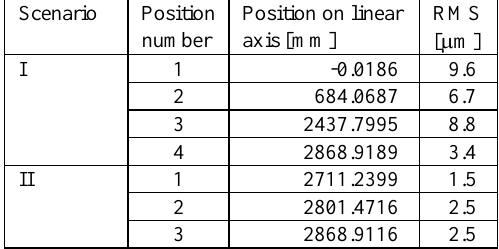
Table 8. Number of positions and distances for image acquisition.